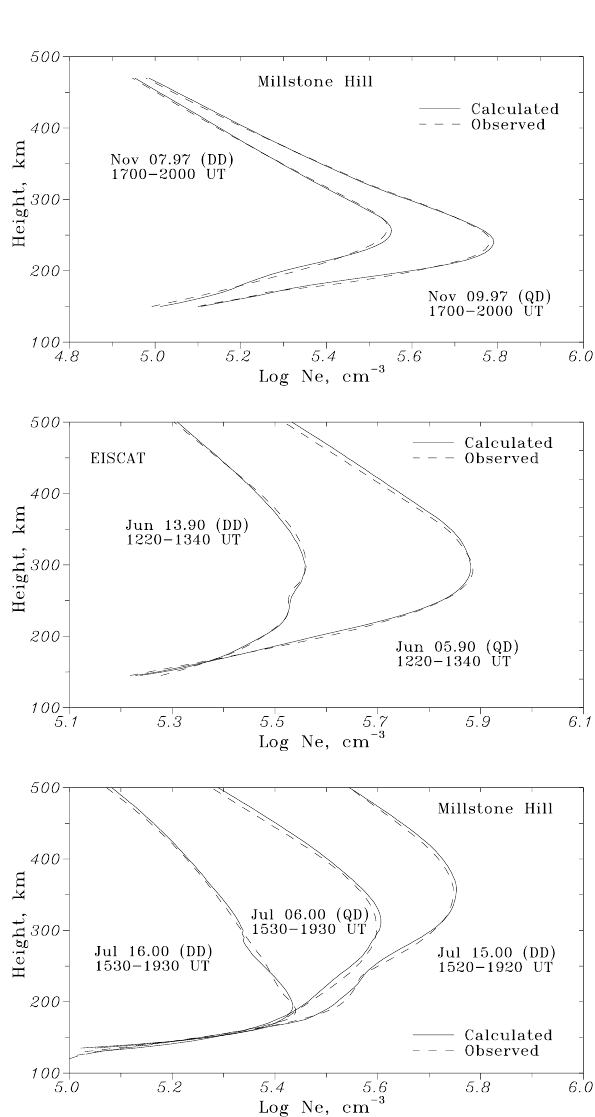
Fig. 2. Observed (corrected on ion composition) and calculated Ne(h) profiles for winter (7/9 November 1997), summer (13/5 June 1990) and a very severe geomagnetic storm on 15–16 July 2000.